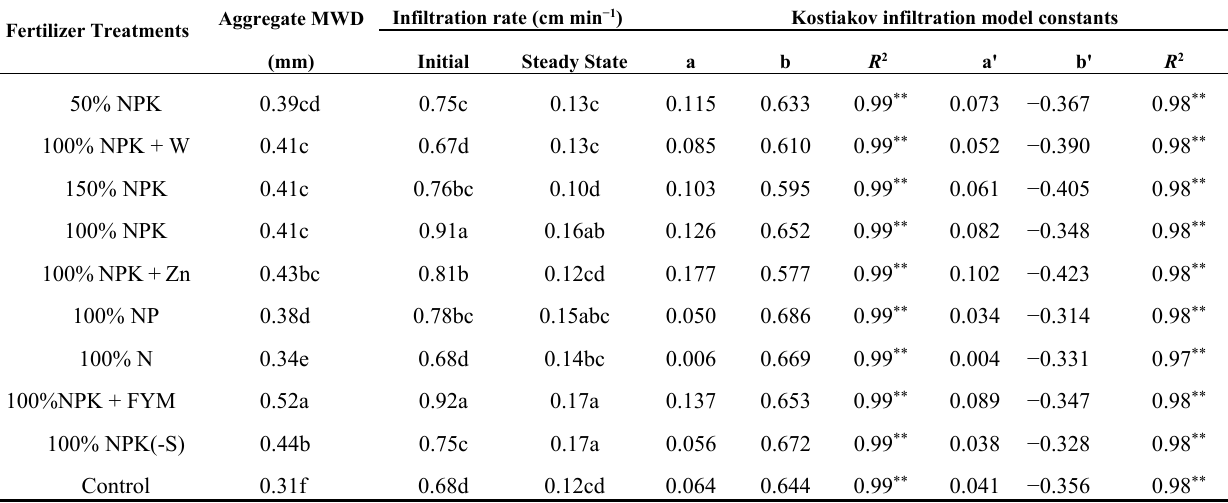
Same letter within each column indicate no significant differences among the treatments ( P ≤ 0.05); ** Significant at 5%